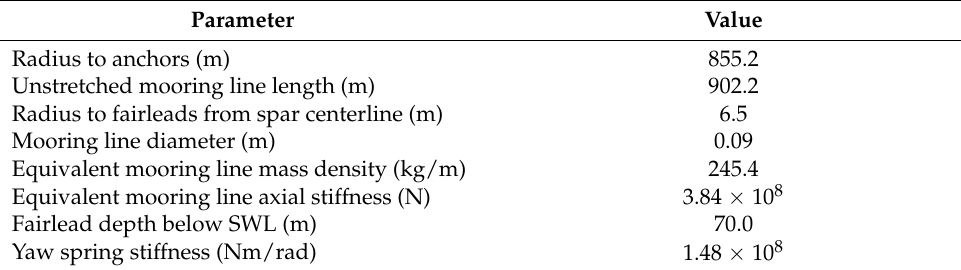
Table 4. The parameters of the mooring